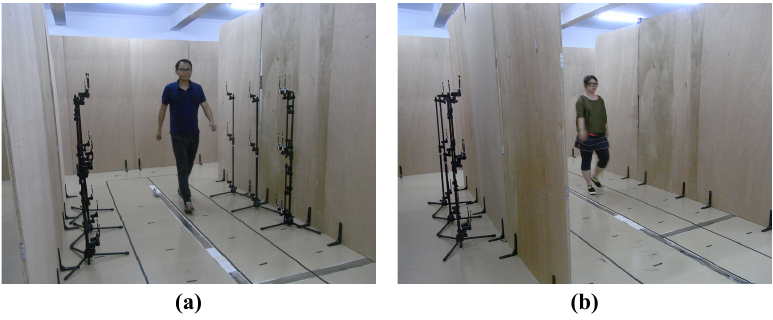
Figure 3. Experimental setup for walker classification in: ( a ) LOS scenario; ( b ) NLOS scenario.